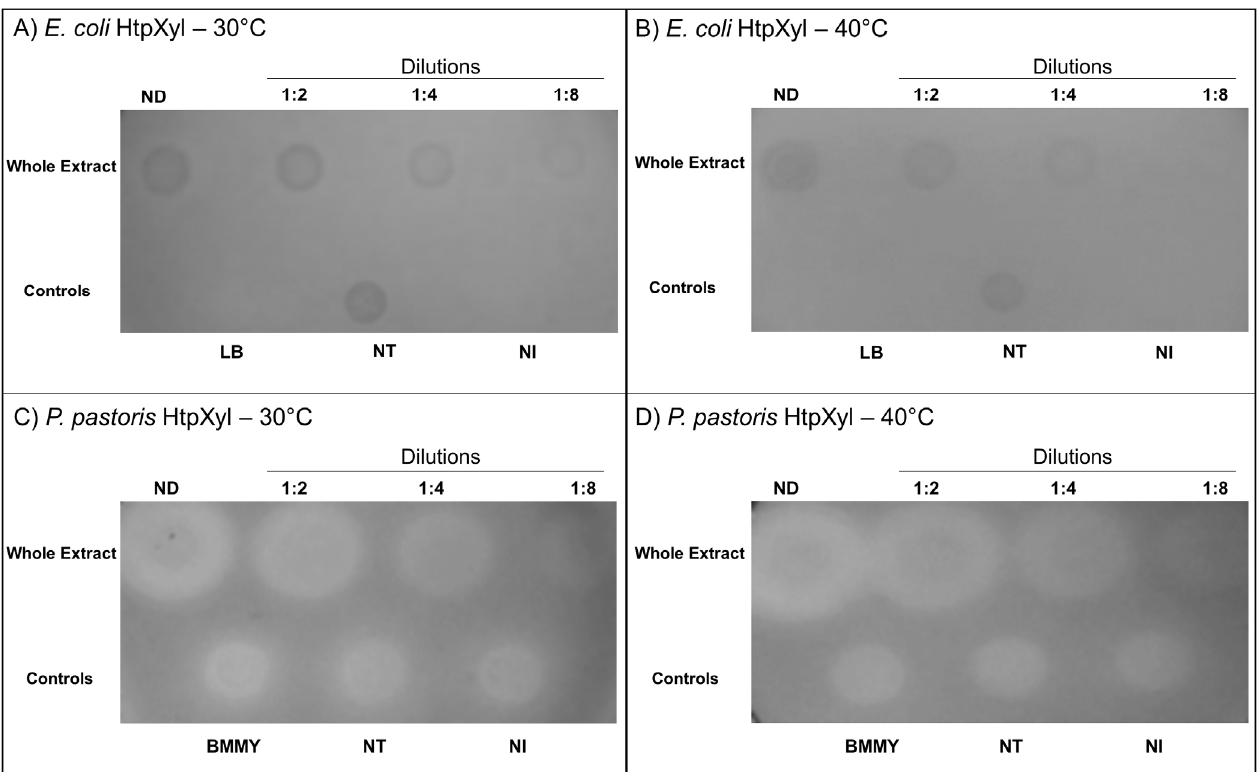
Figure 5. Xylanolytic activity test of HtpXyl in whole protein extract (~5 ug) extracted from E. coli and tested at ( A ) 30 °C and ( B ) 40 °C, and from P. pastoris at ( C ) 30 °C and ( D ) 40 °C, on 1% birch xylan agar plates stained with 0.2% Congo red. Lighter/whiter zones (halos) indicate xylan degradation. ND = sample non-diluted; NT = without plasmid, non-transformed; and NI = no induction.